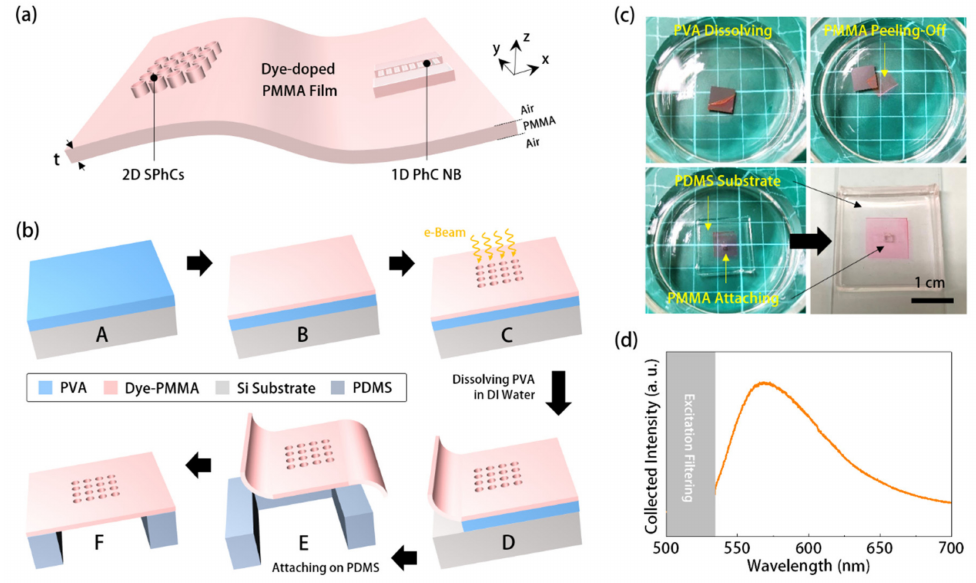
Figure 1. ( a ) Schematics of PhC resonators on a dye-doped PMMA thin film suspending in the